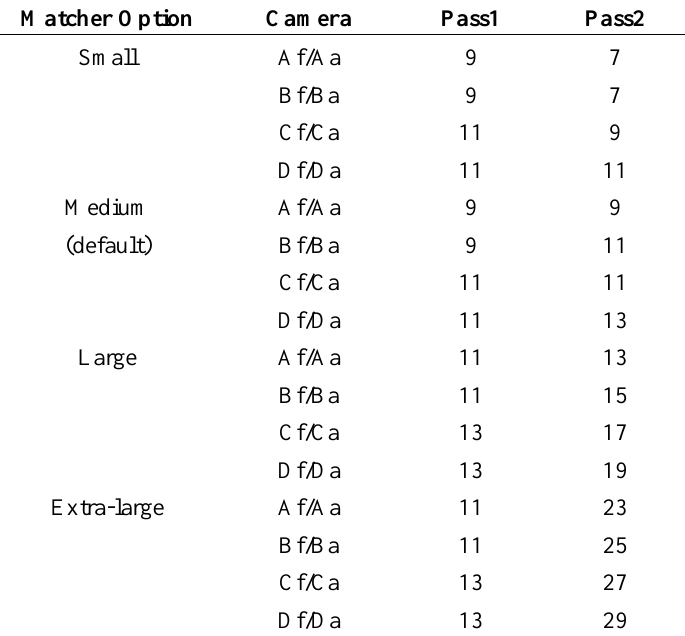
Table 2. Matcher template sizes (N × N